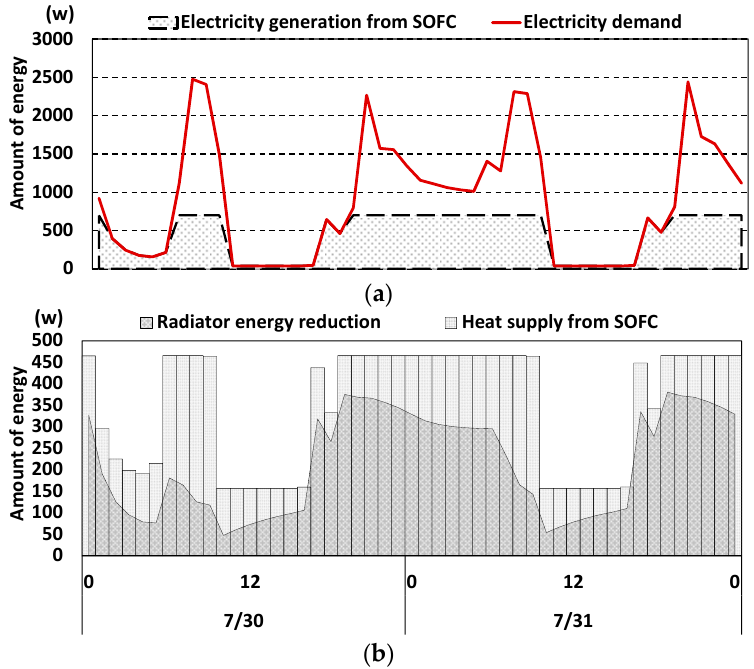
Figure 11. Hourly simulation data of households 2 and 3. ( a ) Data of electricity generation and electricity demand; ( b ) Data of heat reduction and heat supply.